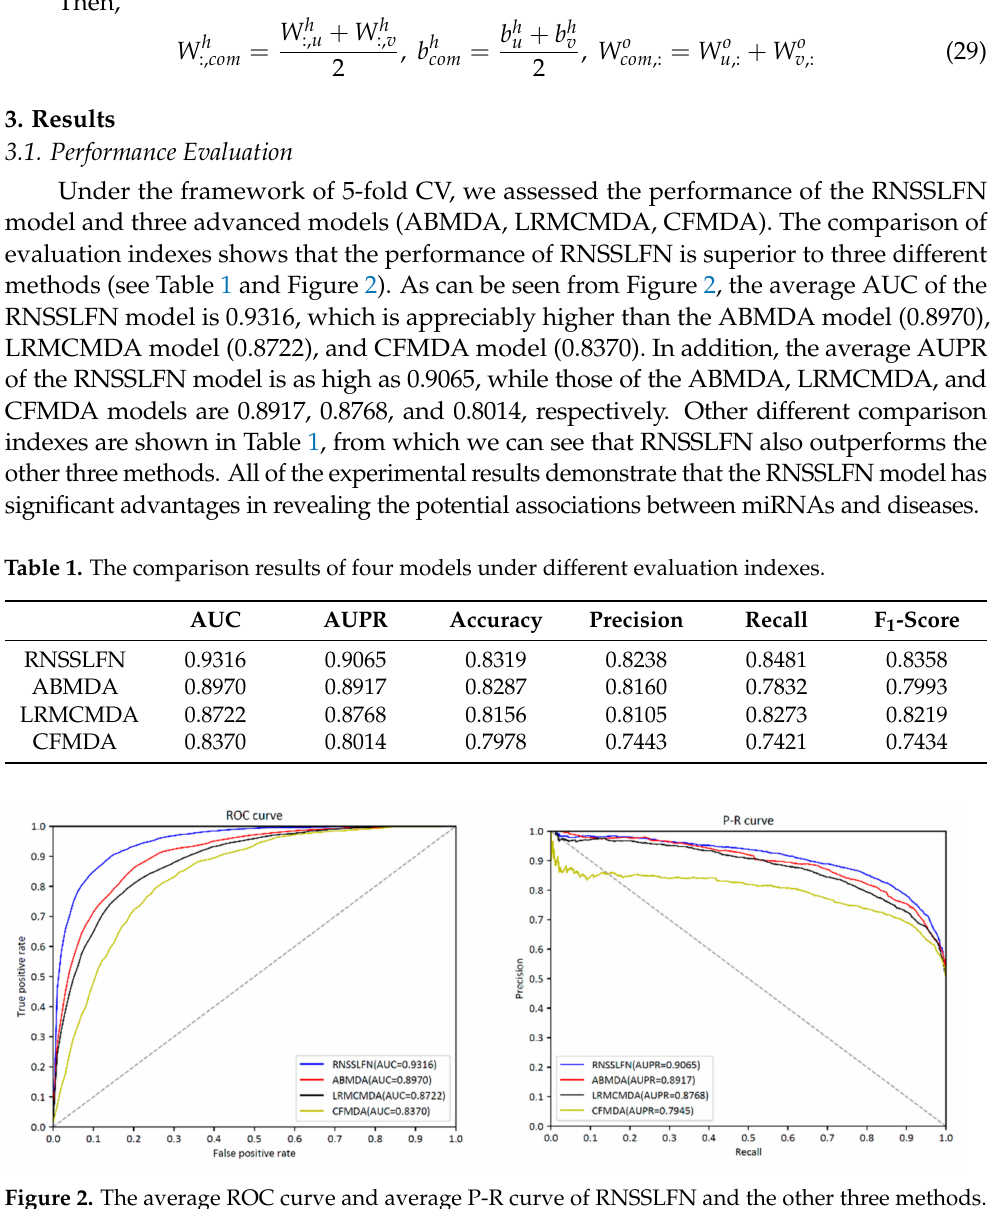
Figure 2. The average ROC curve and average P-R curve of RNSSLFN and the other three